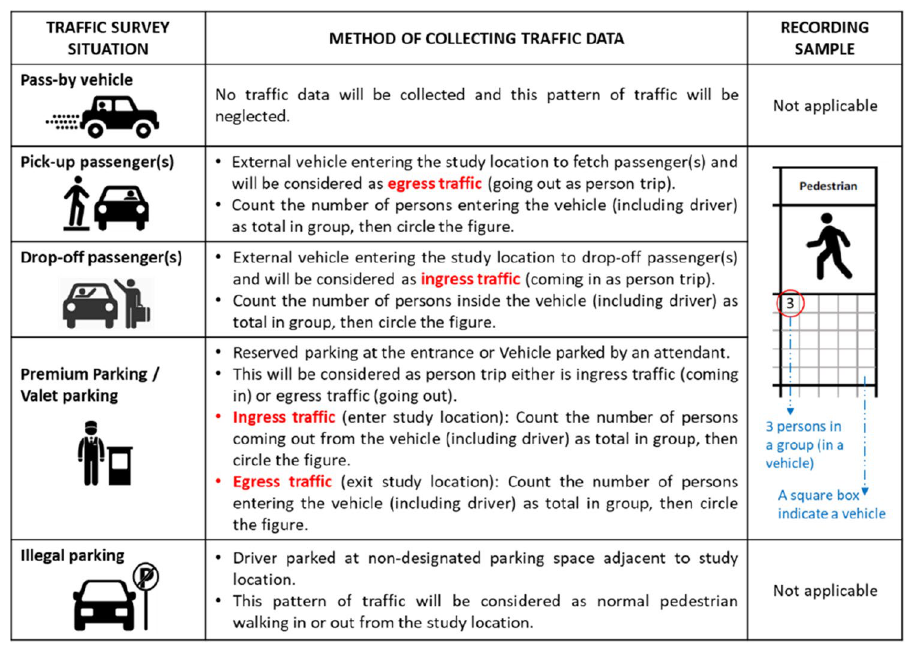
Figure 2. Guidelines for traffic survey (Pedestrian